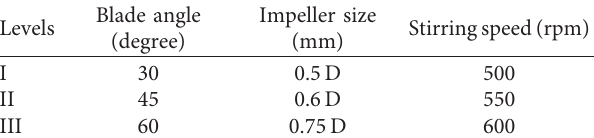
Table 2: Factors and levels [51].